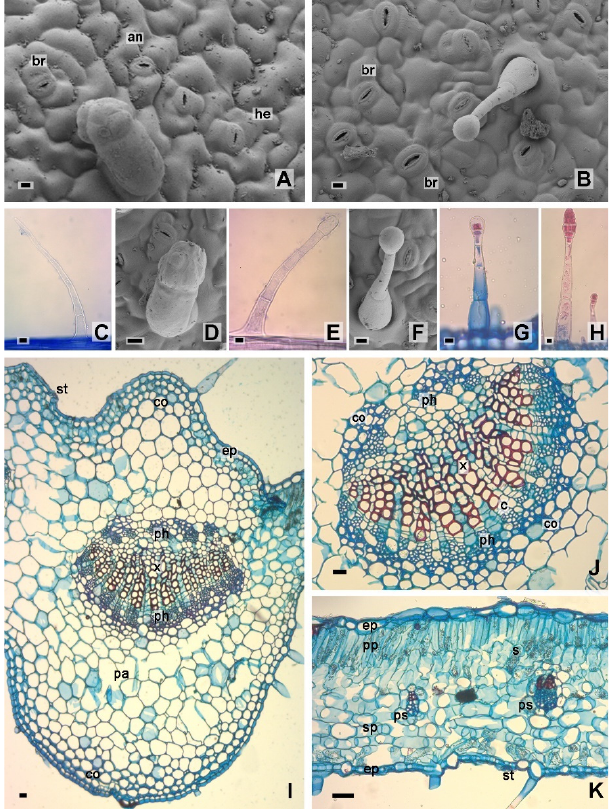
Table 1. Nicotiana tabacum var. Virginia. Length, width, and stomatal density in leaf epidermis. Stomata